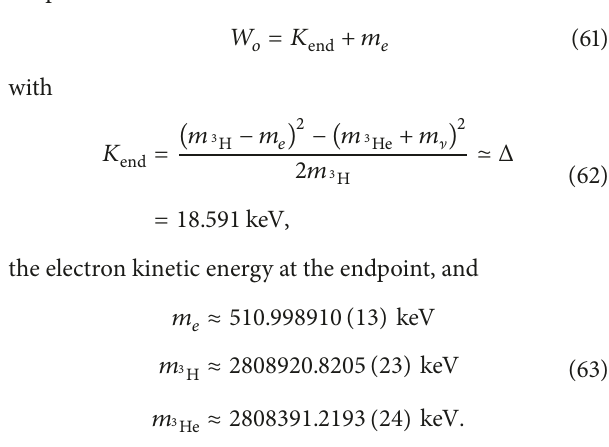
Figure 7: Ratio of decay rates 𝑅 ] /𝑅 𝛽 (in units of 𝐶 2 ] ) as a function of energy resolution 𝛿 near the